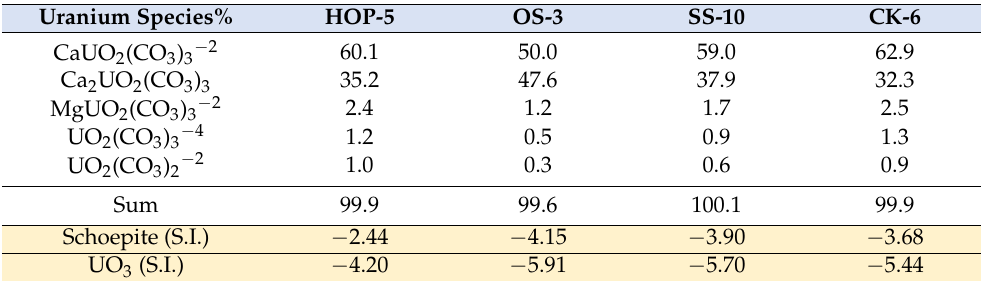
Table 2. Percentage distribution of aqueous uranium species in equilibrium with SSW and mineralogy of the four different rock types, organic-rich phosphorite (HOP-5), bituminous limestone marl (OS-3), sandstone (SS-10), and chalk (CK-6), using 5 mg/L of uranium; also shown are saturation indices for uranyl oxide and hydroxide. Uranium Species% HOP-5